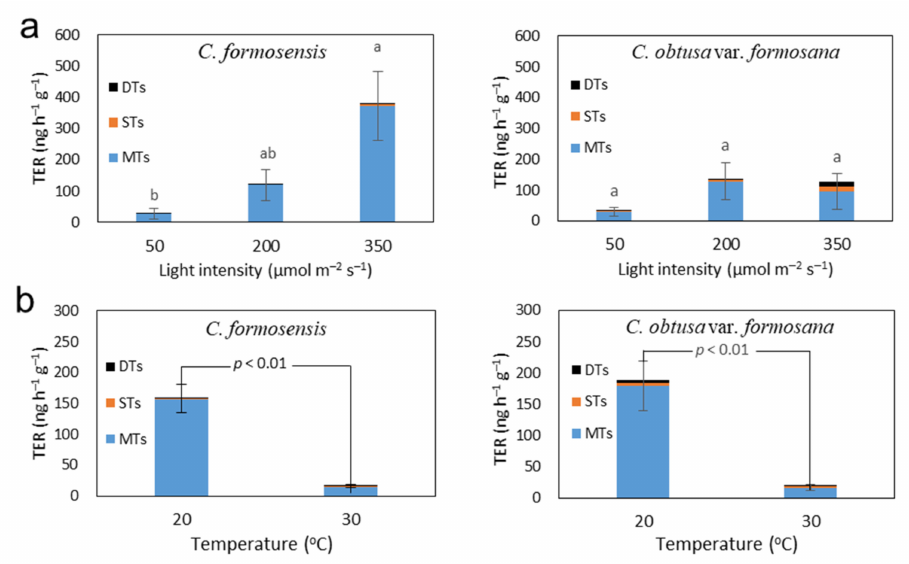
Figure 3. Total BVOC emission rates (TERs) of C. formosensis and C. obtusa var. formosana saplings grown at ( a ) different light intensities under 20 ◦ C, and ( b ) different temperatures under 200 µ mol m − 2 s − 1 light intensity. MTs, monoterpenoids; DTs, diterpenoids; STs, sesquiterpenoids. Bars (mean ± s.e., n = 3) with different letters denote significant difference in means among the three light intensities at p < 0.05 level by Scheffe’s